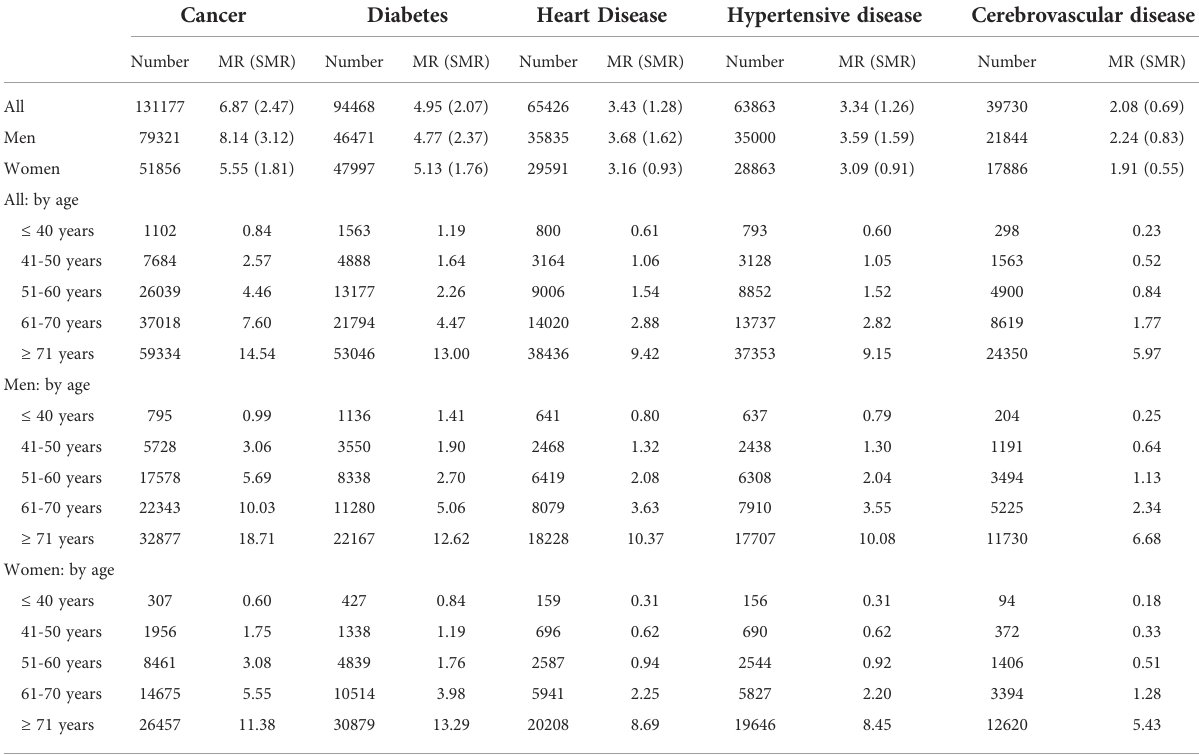
TABLE 3 Major causes of death in patients with diabetes between 2007 and 2017 (follow up to the end of 2018). Cancer Diabetes Heart Disease Hypertensive disease